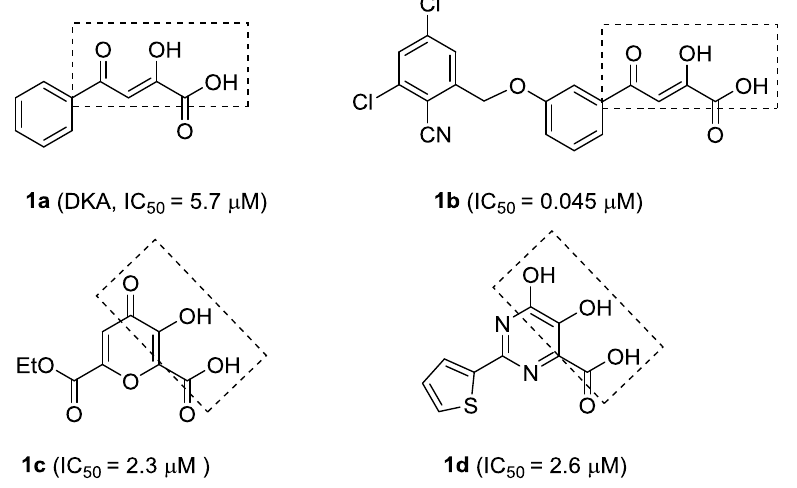
Figure 1. Structures and activities of α,γ-diketoacids (DKAs) and their analogues or isosteric derivatives.